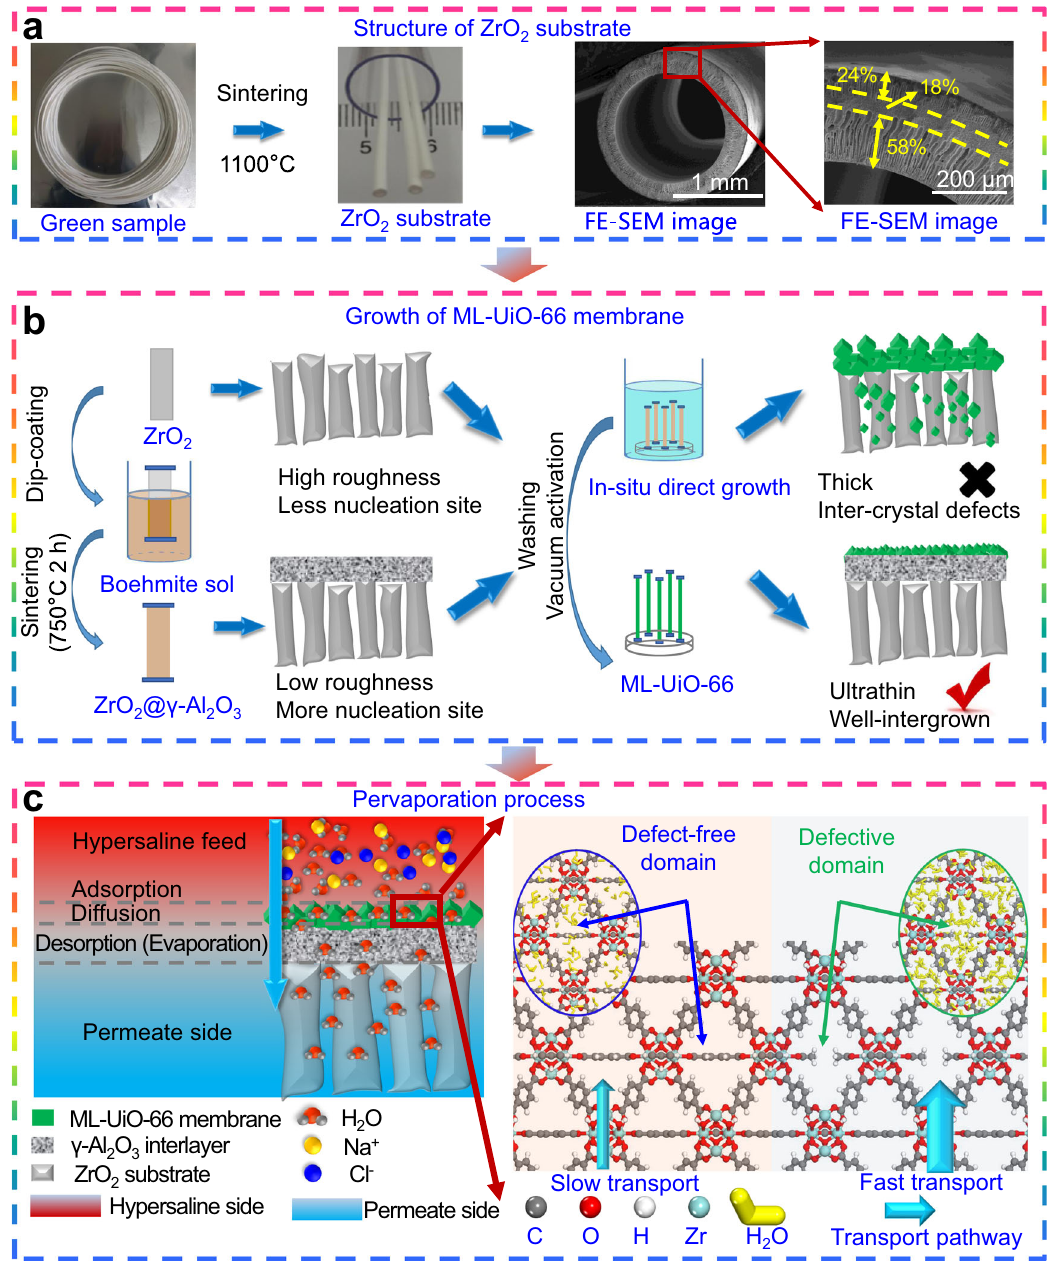
Fig. 1 Schematic diagram of fabrication procedures and desalination mechanistic process of ultrathin ML-UiO-66 membranes via introducing γ -Al 2 O 3 interlayer onto scalable coarse ZrO 2 ceramic substrates (denoted as ZrO 2 @ γ -Al 2 O 3 hereafter) (Supplementary Figs. 1, 2). a Structure of ZrO 2 ceramic substrate (digital photographs, cross-sectional fi led emission scanning electron microscopy (FE-SEM) image and locally enlarged cross-sectional FE-SEM image). b Fabrication of γ -Al 2 O 3 interlayer and growth of ML-UiO-66 membrane. c Pervaporation desalination process (left) and mechanism of intra- crystalline defect-enhanced water permeation